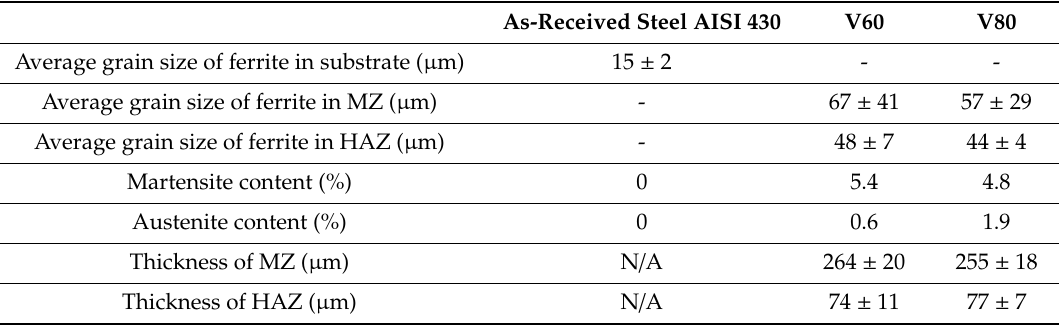
Figure 2. The laser-surfaced melted specimens: ( a ) V60 and ( b ) V80; (i) cross-sectional views (50 × ), (ii) microstructure of melt zone (MZ); (iii) electron backscatter diffraction (EBSD) phase maps of MZ (blue phase is for austenite and red phase is for ferrite); and (iv) microstructure of heat-affected zone (HAZ). Table 3. Average grain size of ferrite, martensite, and austenite contents, thickness of MZ and HAZ of the as-received AISI 430 steel, laser-surface melted specimens V60 and V80.